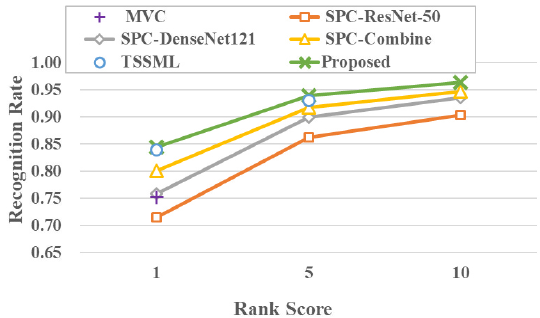
Figure 8. Performance comparison on the Market-1501 dataset.